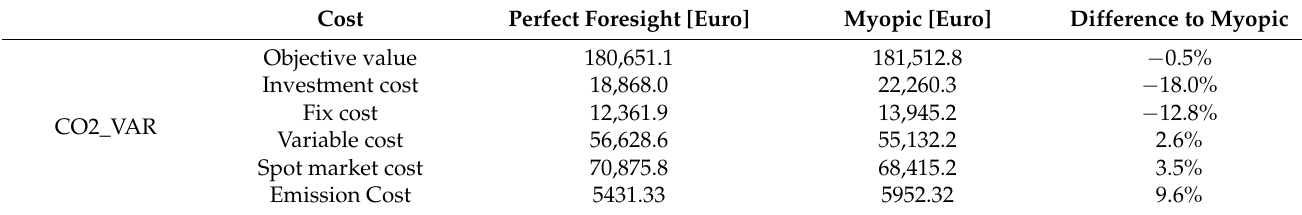
Table 7. Comparison of objective value and costs of the CO2_VAR